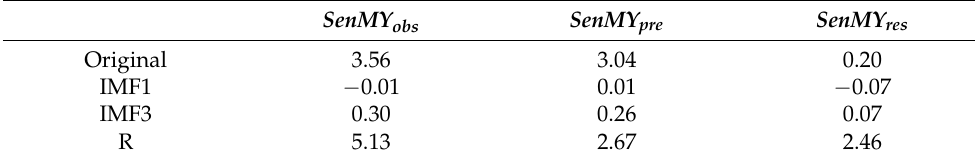
Table 5. The Sen-slope value of human activities and climate change for maize yield over different timescales. SenMY obs SenMY pre SenMY res Original 3.56 3.04 0.20 IMF1 − 0.01 0.01 − 0.07 IMF3 0.30 0.26